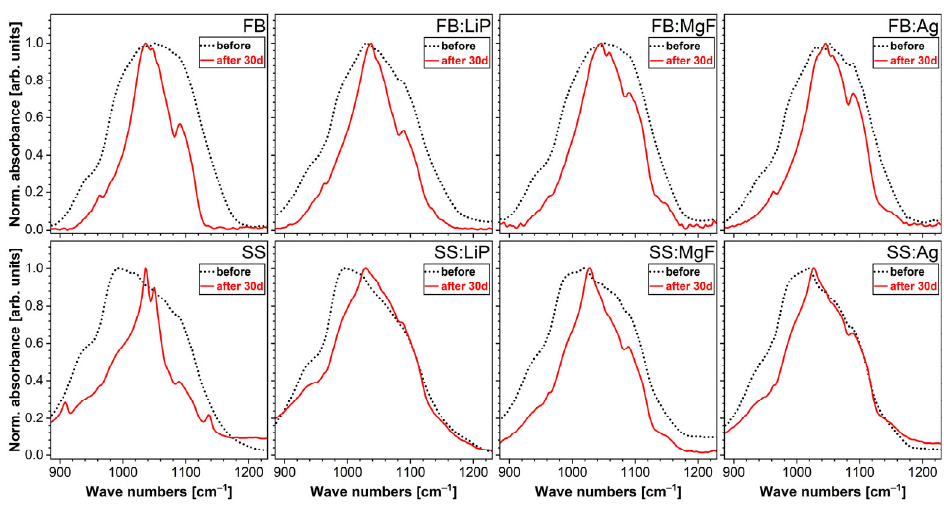
Figure 10. FTIR-ATR spectra of simple and doped FB and SS thin fi lms immersed in SBF for 30 days.